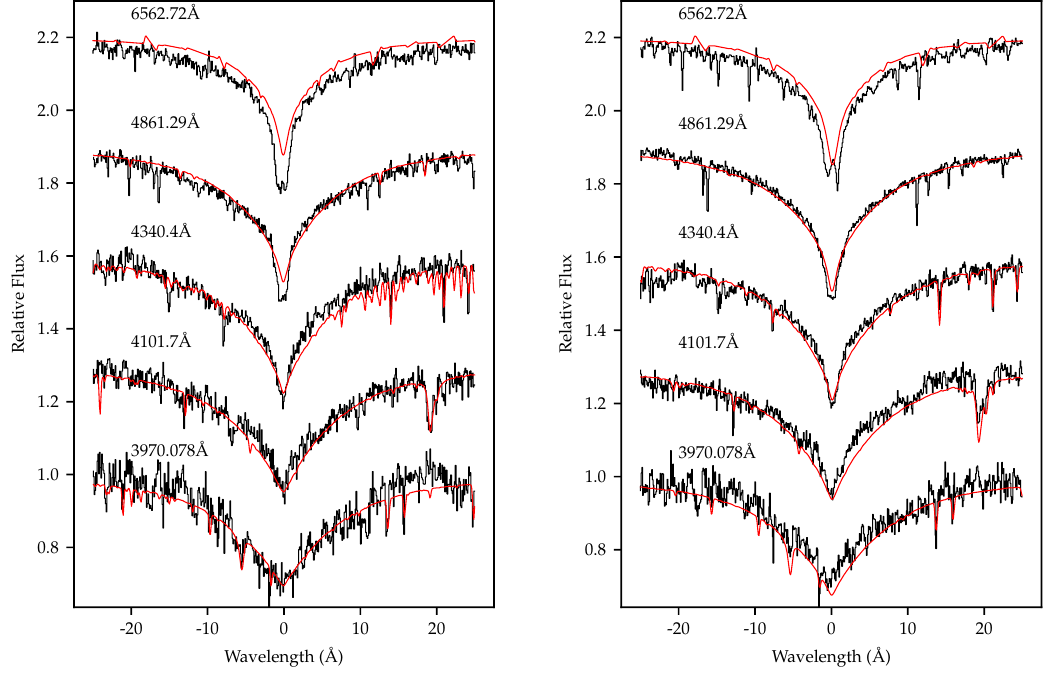
Figure 1. The Balmer series of PG0909+276 (left) and UVO0512–08 (right). Adapted from Wild & Jeffery (2017).